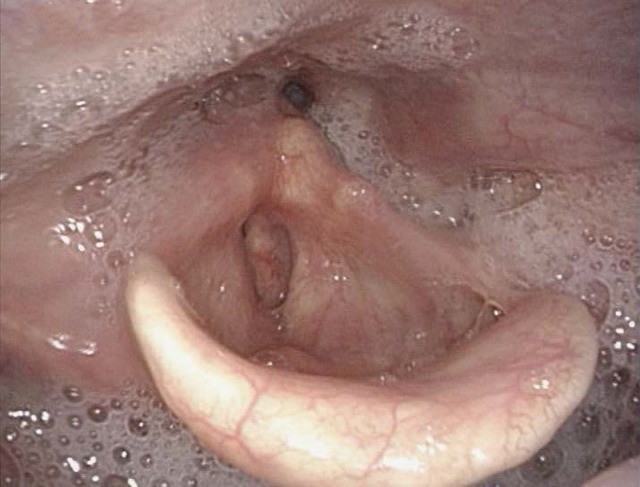
70-year-old female patient with bilateral paresis of the vocal folds after total thyroidectomy, neck dissection, radiation. Chronic radio-dermatitis. The larynx is clearly displaced in a ventral direction due to scars. Impaired supraglottic sensitivity. The upper esophageal sphincter is open, pooling of foamy saliva. Penetration.